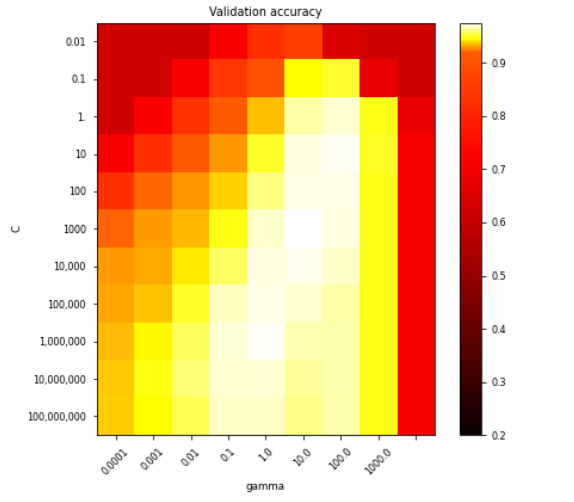
Figure A2. SVC radial basis function parametrization.